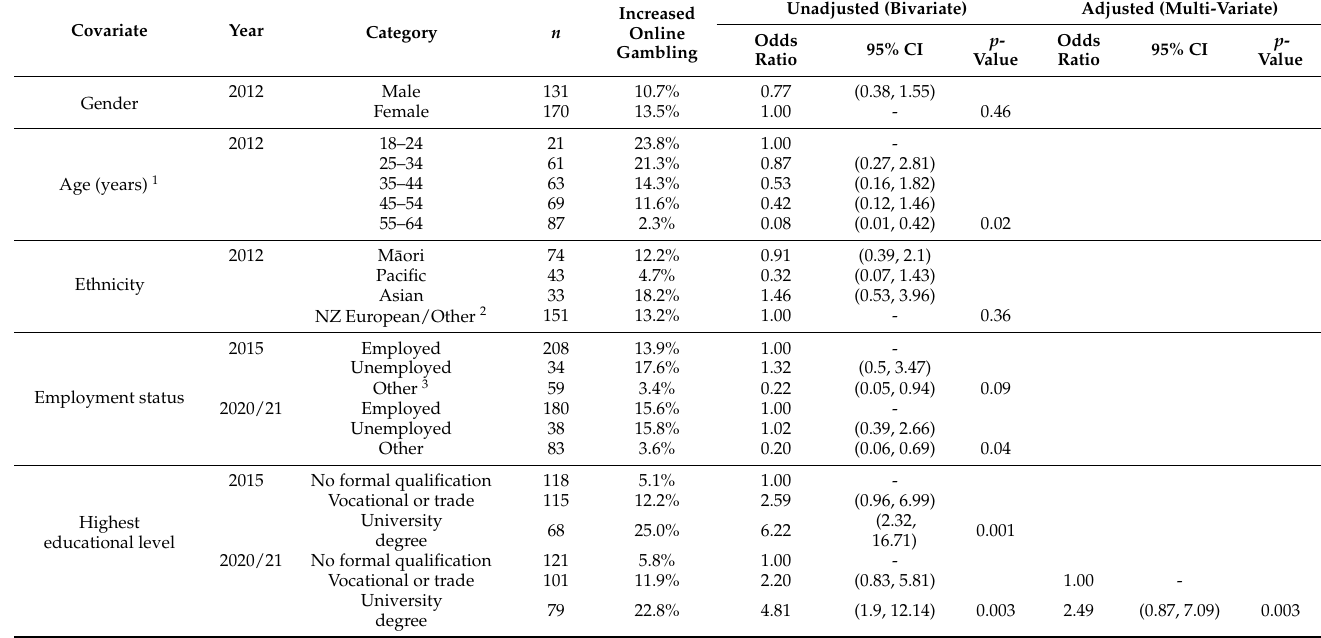
Table 5. Increased online gambling during lockdown—logistic regression